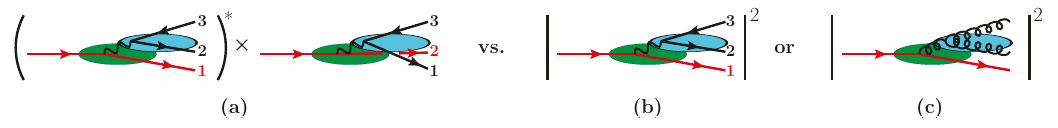
Figure 11 . For overlapping formation time contributions to the splitting of a fermion, a comparison of contributions to the rate where identi(cid:12)cation of the direct heir of the parent fermion (a) is or (b), (c) is not ambiguous. (a), (b) apply to both QED and QCD (with the wavy line a photon or gluon respectively), whereas (c) applies only to QCD. (b) dominates over (a) in large- N f QED, and (c) dominates over both (a) and (b) in large- N c